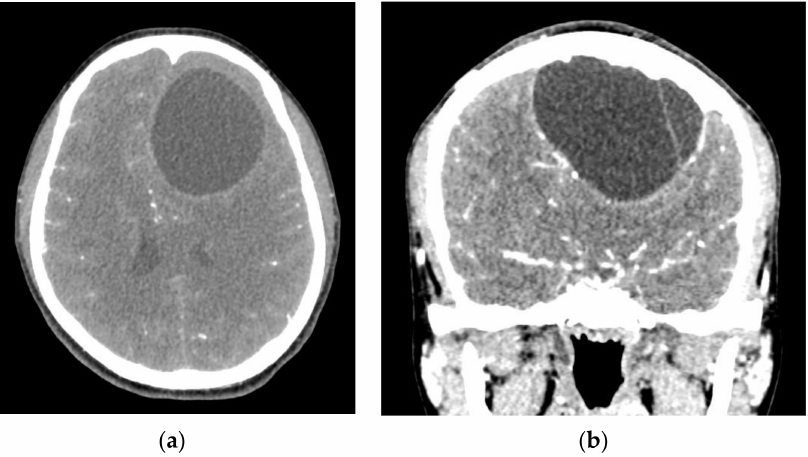
Figure 3. Cranial computed tomography (CT) scans with intravenous (IV) contrast. ( a ) axial; ( b ) coronal.